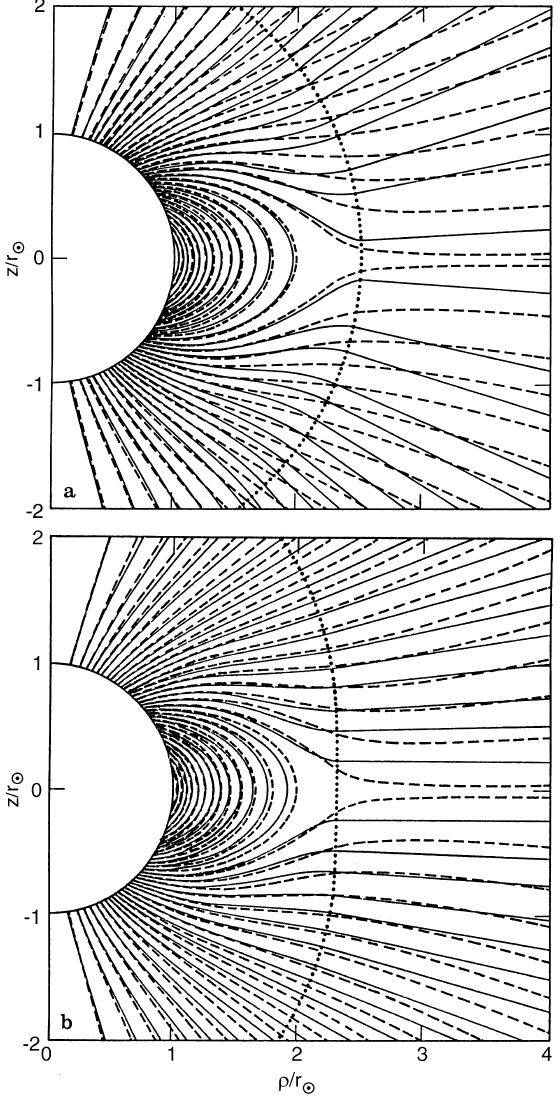
Fig. 1a,b. Representative field lines emanating from selected photo- spheric latitudes in various coronal magnetic-field models, applied to the case in which the Sun’s field is dipolar. Dashed curves correspond to MHD model of Pneuman and Kopp (1971a,b) in both panels. Solid curves correspond to source-surface models: a with spherical source surface ( dotted curve ) of radius r (cid:136) 2 : 5 r (Altschuler and (cid:12) Newkirk, 1969), corresponding to k (cid:136)1 in present notation; and b with ‘‘dipole-isogauss’’ source surface ( dotted curve ) of variable radius r (cid:136) 2 : 3 (cid:133) 1 (cid:135) 3cos 2 (cid:134) 1 = 6 r (Schulz et al. , 1978), corresponding to k (cid:136) 0 (cid:12) in present notation ( (cid:104) (cid:17)